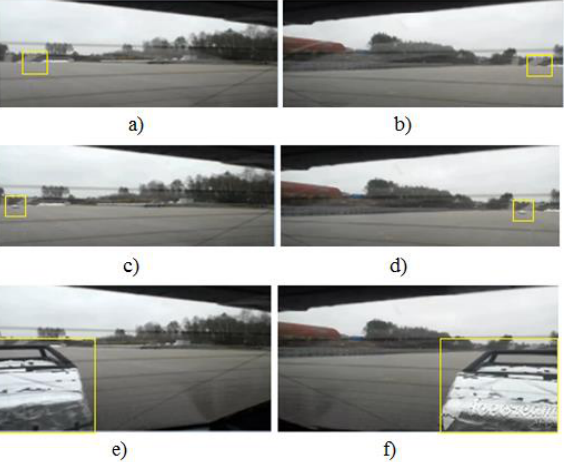
Figure 7. Real video data used for the last experiment, [16]: ( a ) right camera before car starting; ( b ) left camera before car starting; ( c ) right camera during car moving; ( d ) left camera during car moving; ( e ) right camera after car stopping; ( f ) left camera after car stopping.